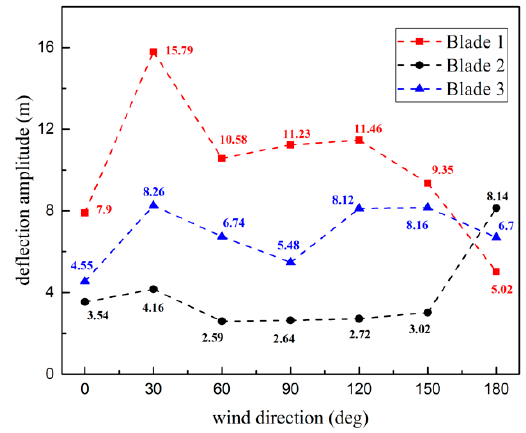
Figure 6. Comparison of the maximum tip